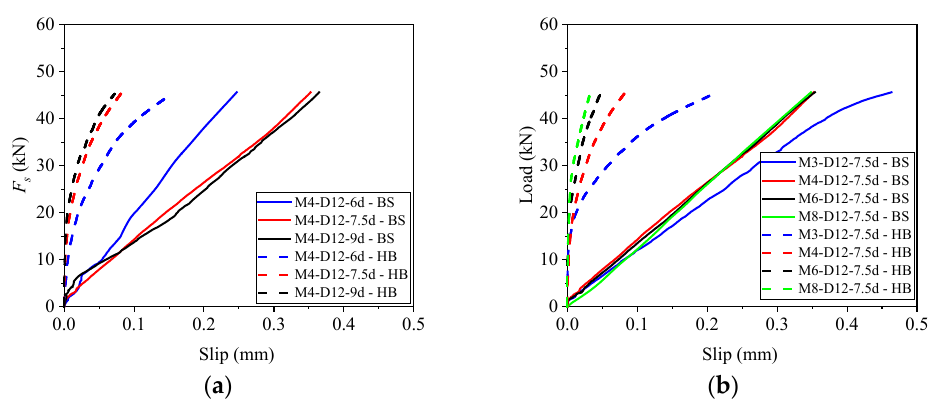
Figure 26. Load–slip curves ( a ) Comparison of different lap length; ( b ) Comparison of different head size.